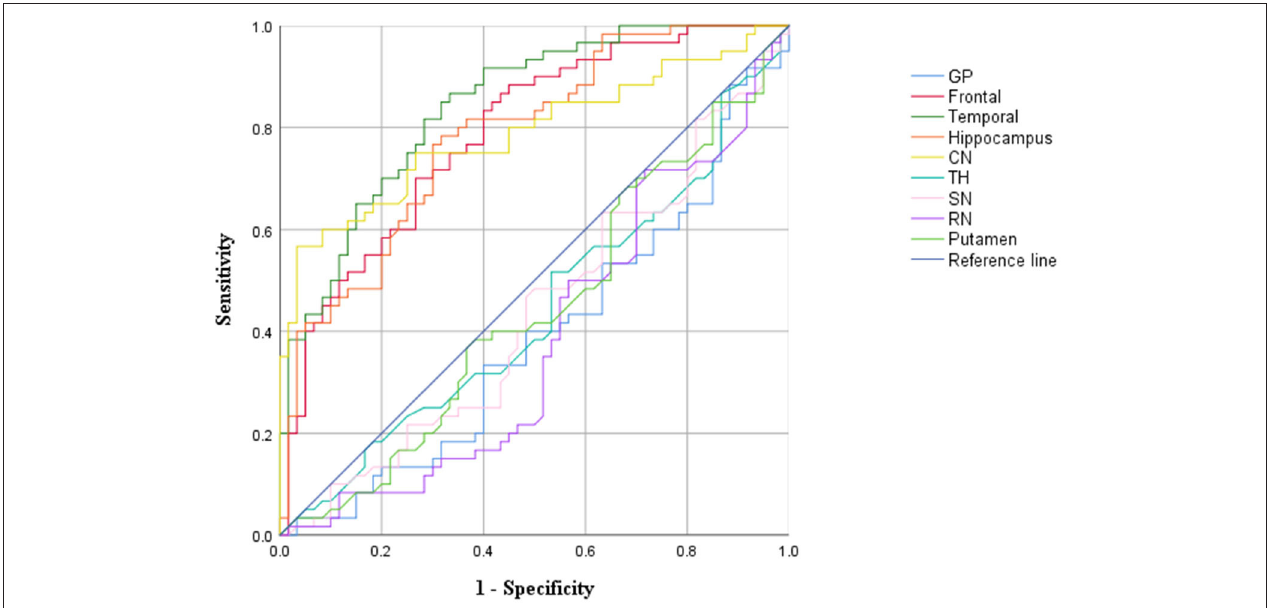
FIGURE 5 | ROC curve analysis results of CBF values in brain region.